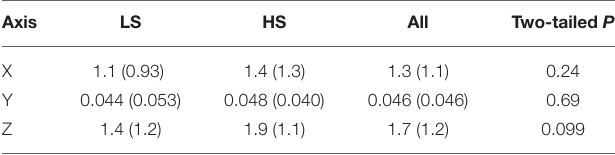
TABLE 4 | Position asymmetry index in each axis.